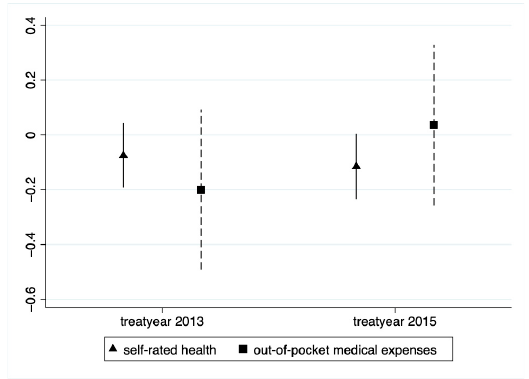
Figure 4. Parallel trend test.